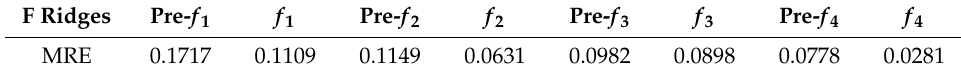
Figure 10. Processing results of the low and resonant frequency band signals of the outer race fault signal using the proposed FMLT: ( a ) FMLT-resulting TFR of the lower frequency band signal, ( b ) FMLT-resulting TFR of the resonant frequency band signal, ( c ) extracted IF ridges from ( a ) using FPO, and ( d ) extracted IF ridges from ( b ) using FPO. Table 2. MREs of extracted IF ridges of outer race fault signal.